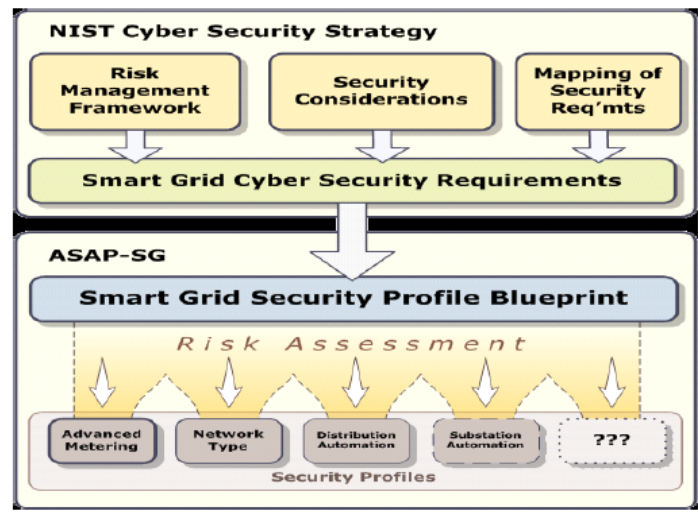
Figure 3. NIST Cyber Security Strategy. ASAP-SG: advanced security acceleration project for smart grid; NIST: national institute of standards and technology.